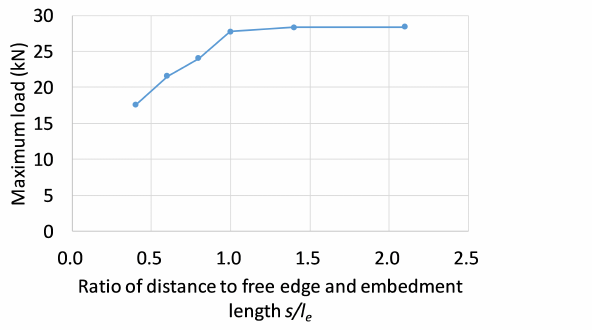
Figure 28. Relationship between maximum load and ratio of distance free edge and embedment depth s / l e